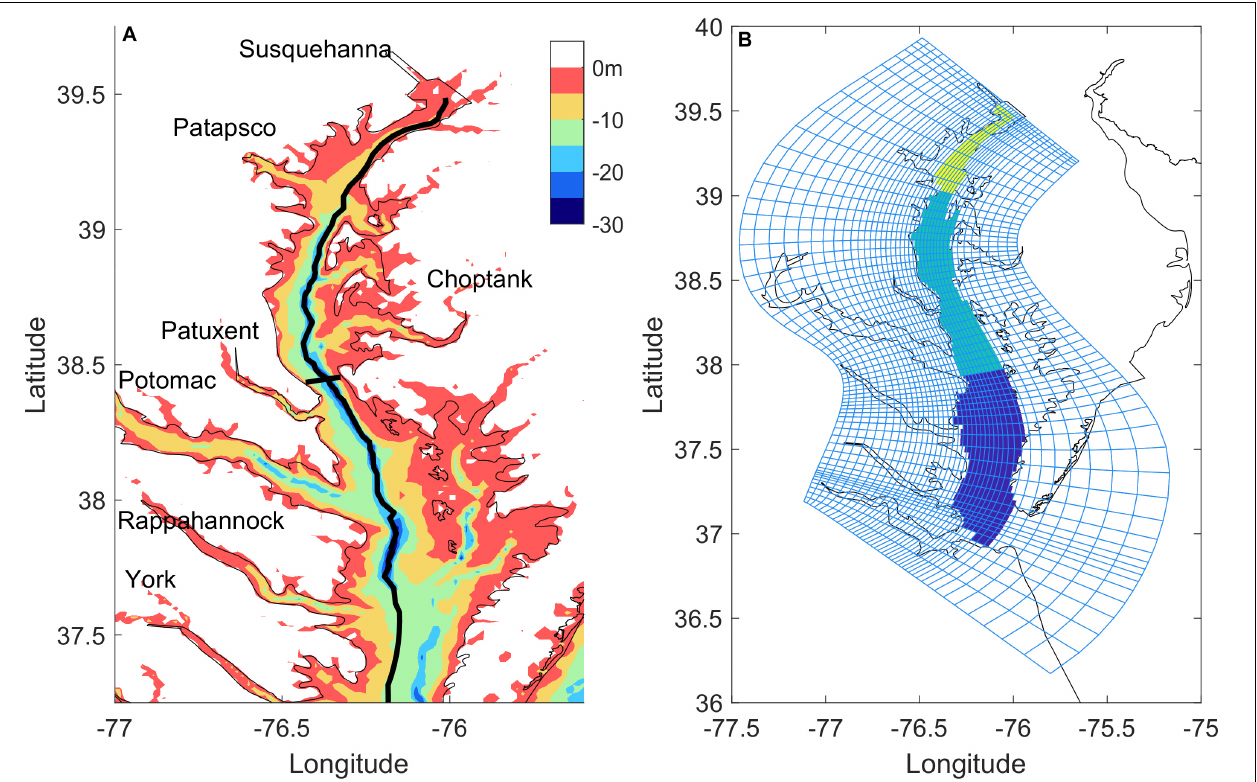
FIGURE 1 | Map showing bathymetry (A) and model grids (B) for Chesapeake Bay. The black lines in (A) marks the along-channel section and a cross-channel section in the mid-Bay used in later analysis. The shaded areas in (B) represent the upper, middle, and lower-Bay